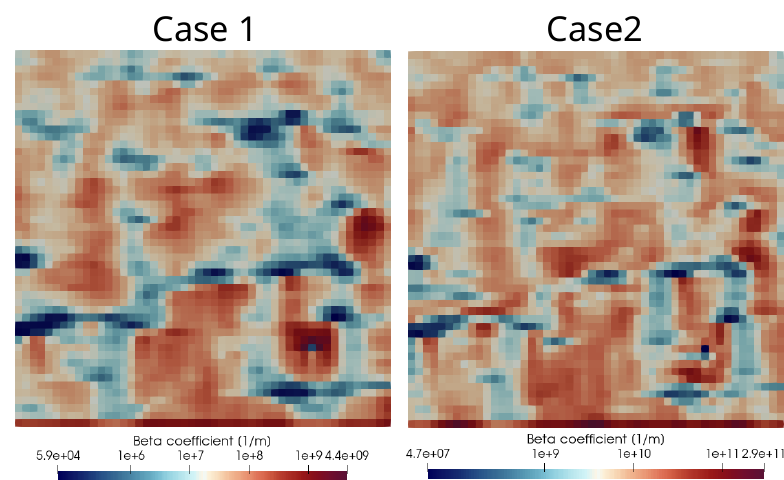
Figure 7. Spatial Forchheimer coefficients for Scenario (a).